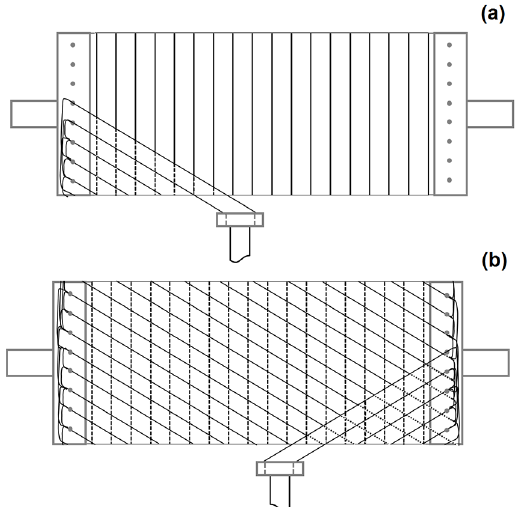
Figure 1. Schematic of superposition winding method for helical layers. Filament winding process at (a) -30º layer and at (b) +30º